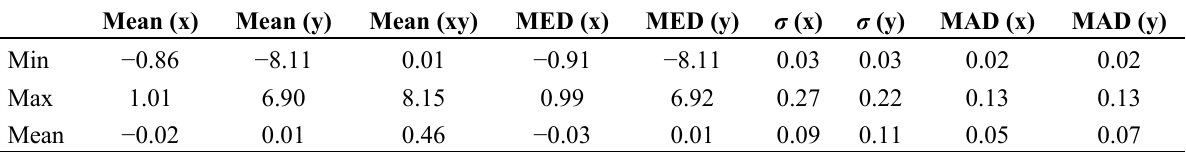
Table 3. Relative accuracy evaluation; statistical values of shifts (x) and (y) from all